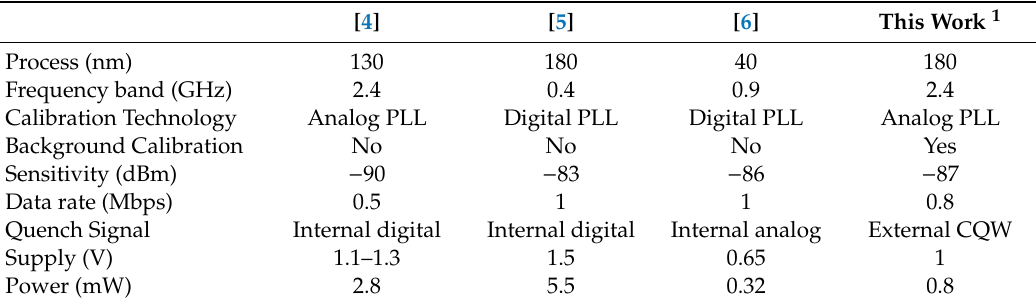
Table 1. Performance table and comparison to the prior